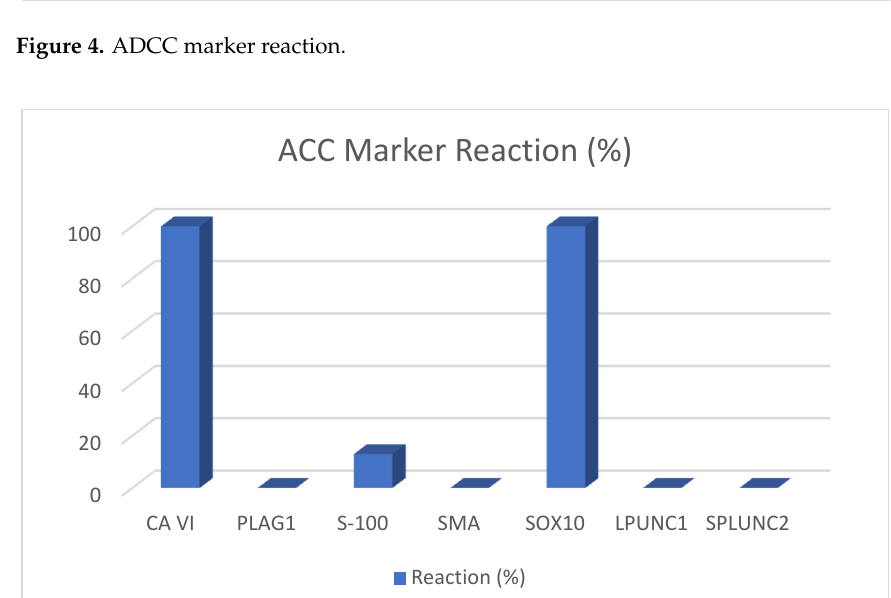
Figure 5. ACC marker reaction.